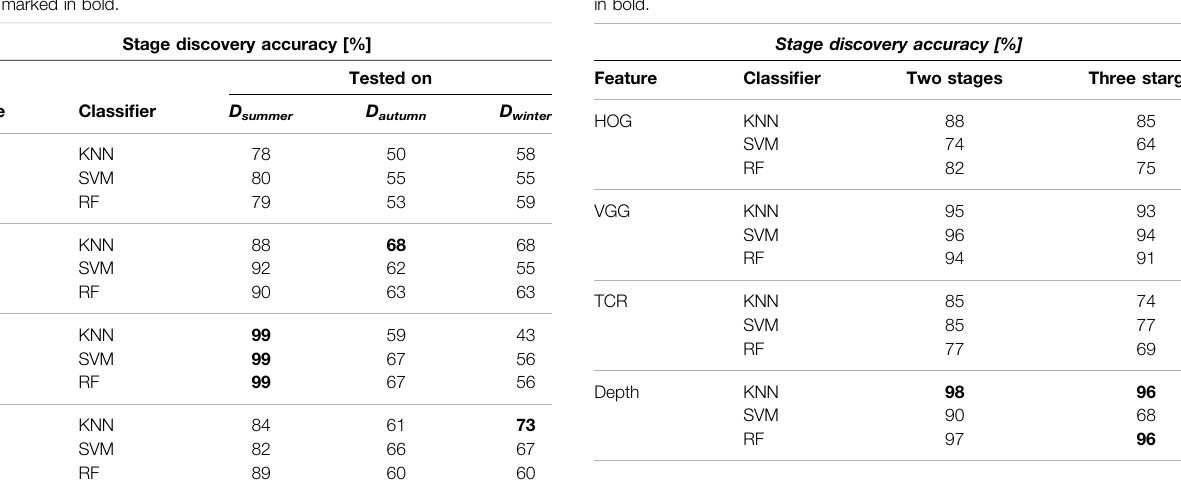
TABLE 2 | Stage discovery accuracy trained on all seasons . We used repeated 2-fold cross-validation, i.e., 50%ofdata wasselectedfor training and